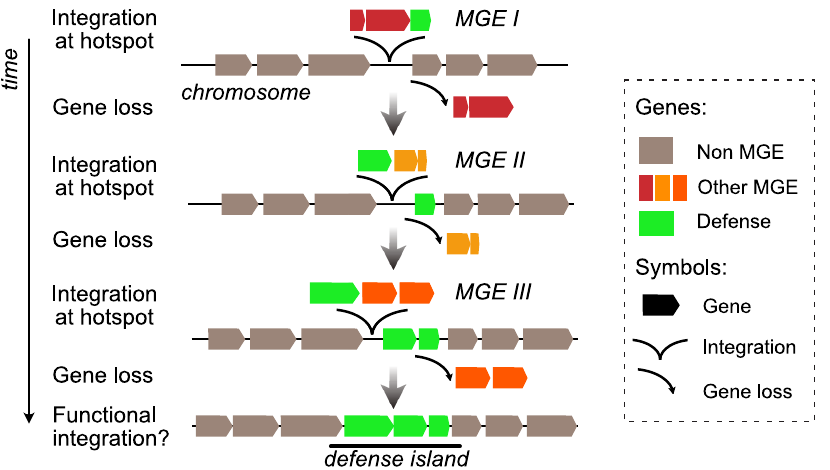
Fig 4. MGE turnover at hotspots may result in defense islands. MGEs tend to integrate the chromosome at a few hotspots and may subsequently be inactivated by mutations resulting in the loss of genes that are not adaptive to the host. The succession of integration/partial deletion of MGEs if accompanied by the co-option of the defense systems may result in clusters (or islands) of defense systems in hotspots. MGE, mobile genetic